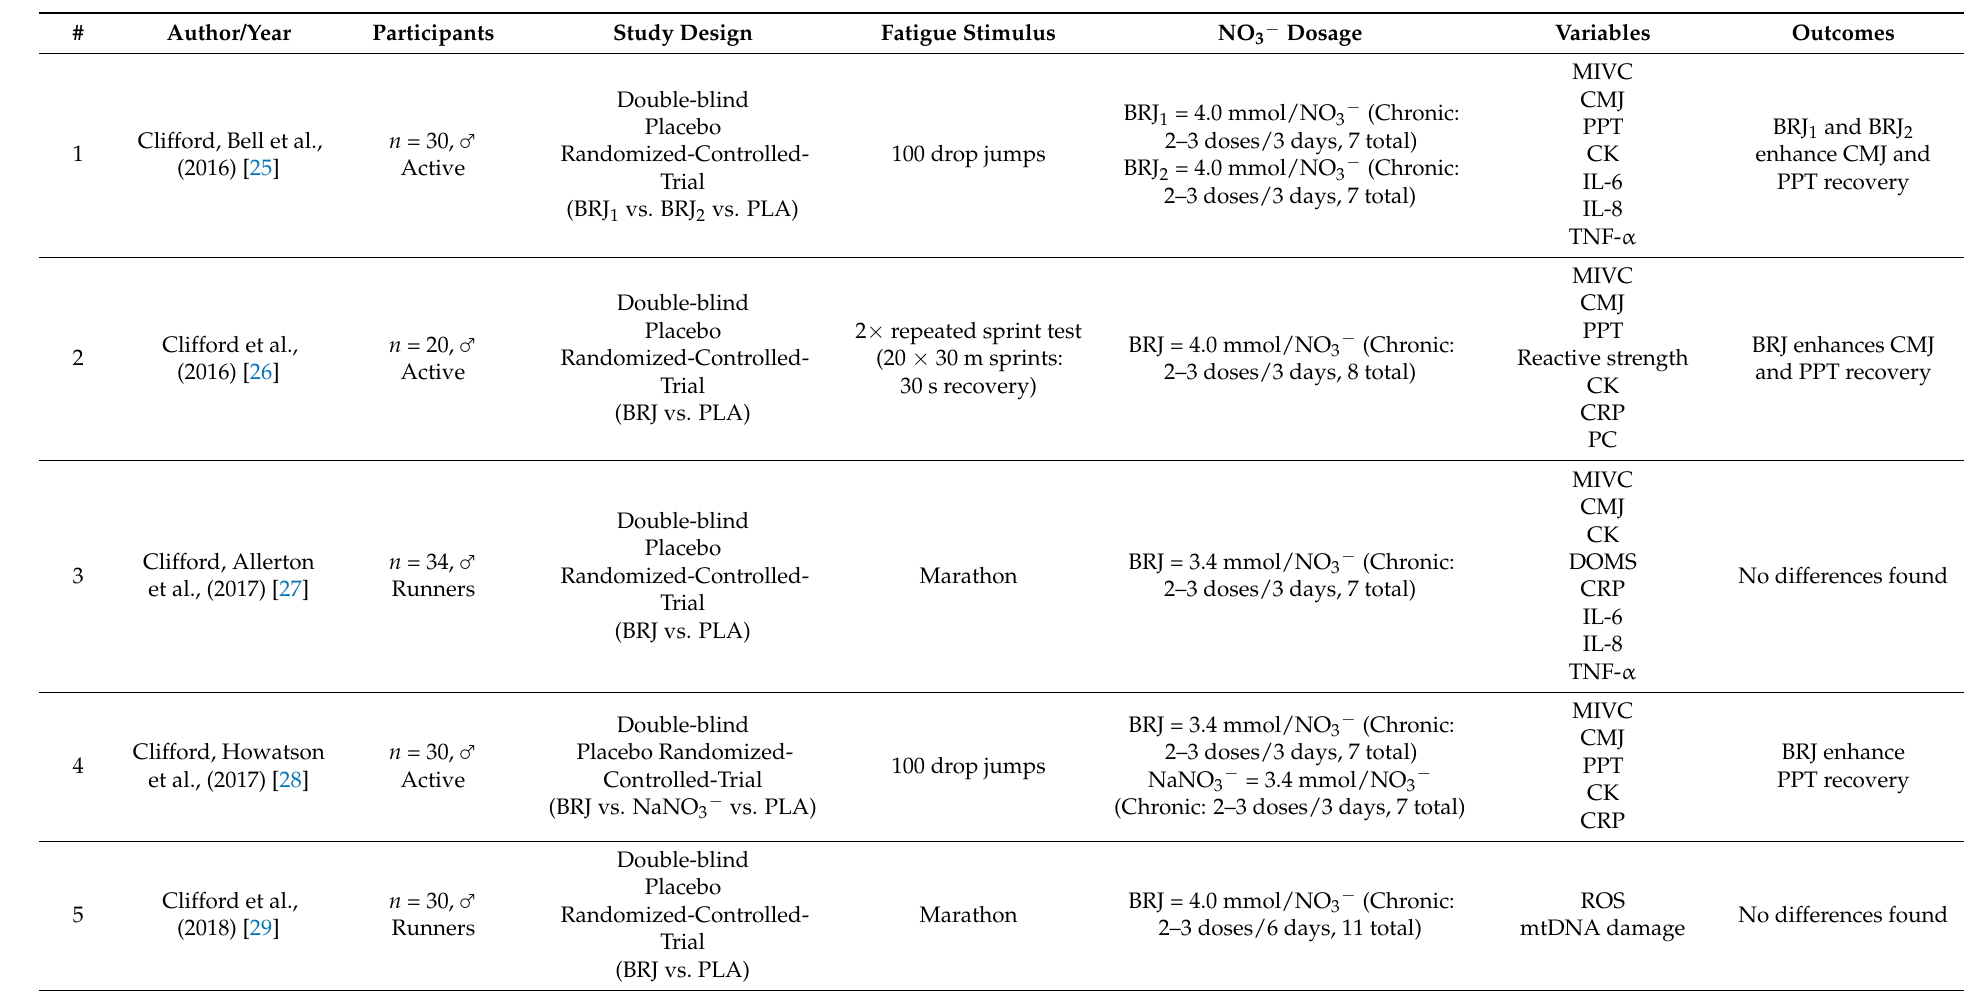
Table 1. Data extracted from the included